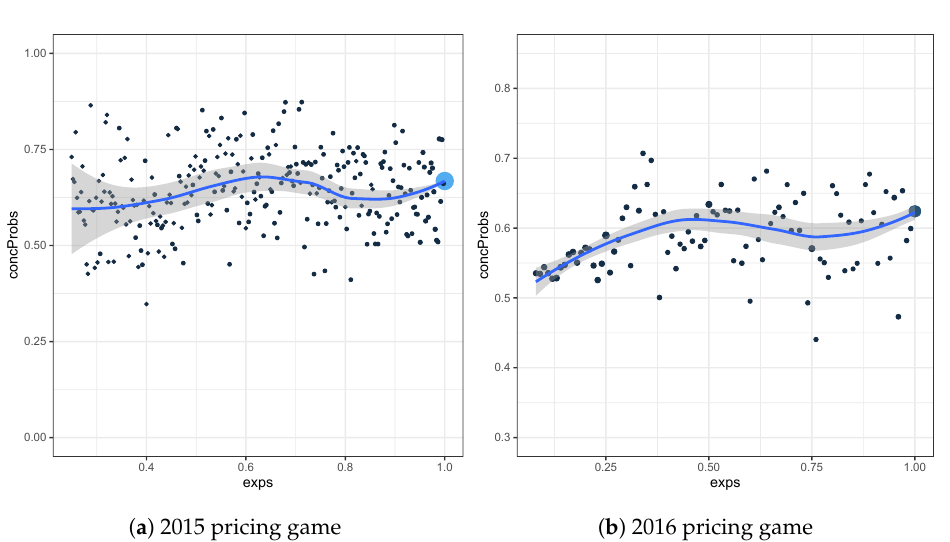
≈ ( λ ,0.05 ) based on the dataset of the 2015 and 2016 pricing Figure A1. Weighted-mean-plot for ˆC M ,0,1 + game. It is obtained by the original marginal approximation, using the number of boundary values that resulted in the lowest